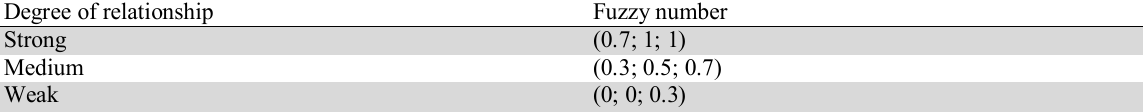
Degree of relationship, graphic symbols and corresponding fuzzy numbers Degree of